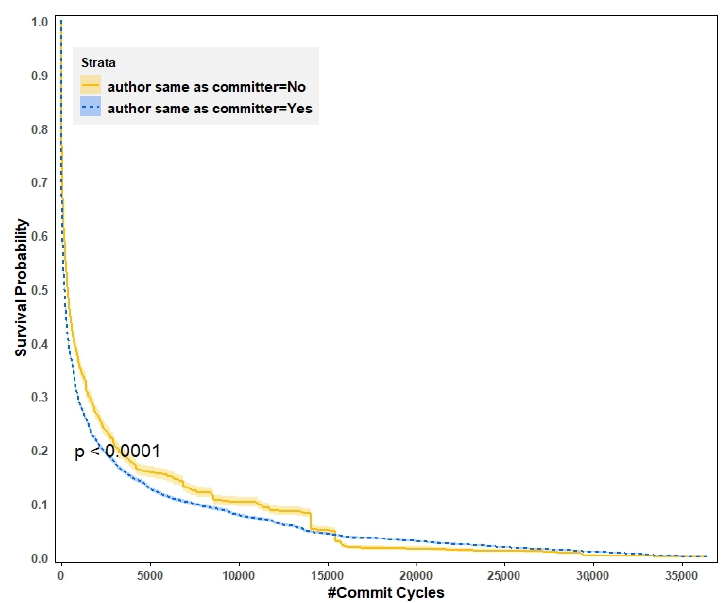
Figure 6. Kaplan–Meier estimations of the survival function for the scenario when bugs are authored and committed by the same